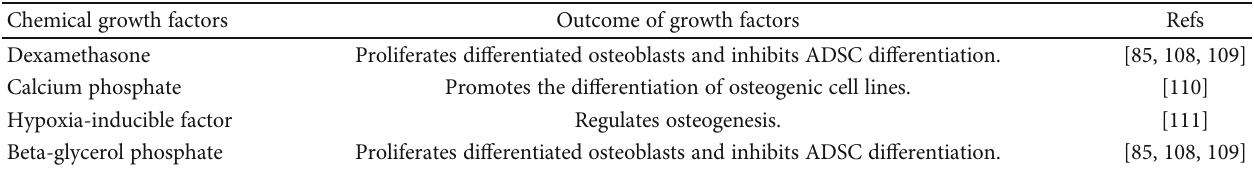
Table 2: Chemical growth factors introduced to ADSCs for osteogenic di ff